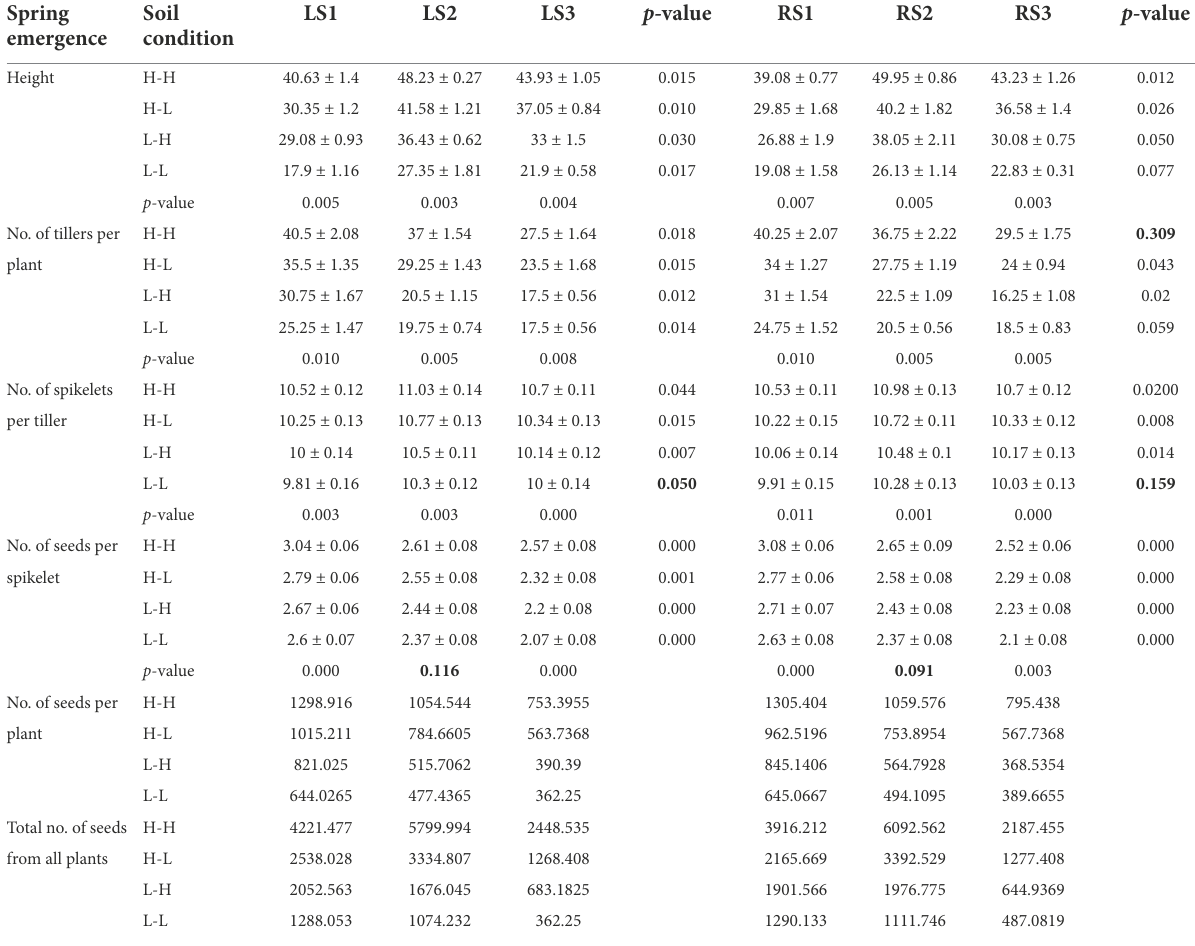
TABLE 2 Plant size and seed production of Aegilops tauschii from spring germinating seeds. Spring